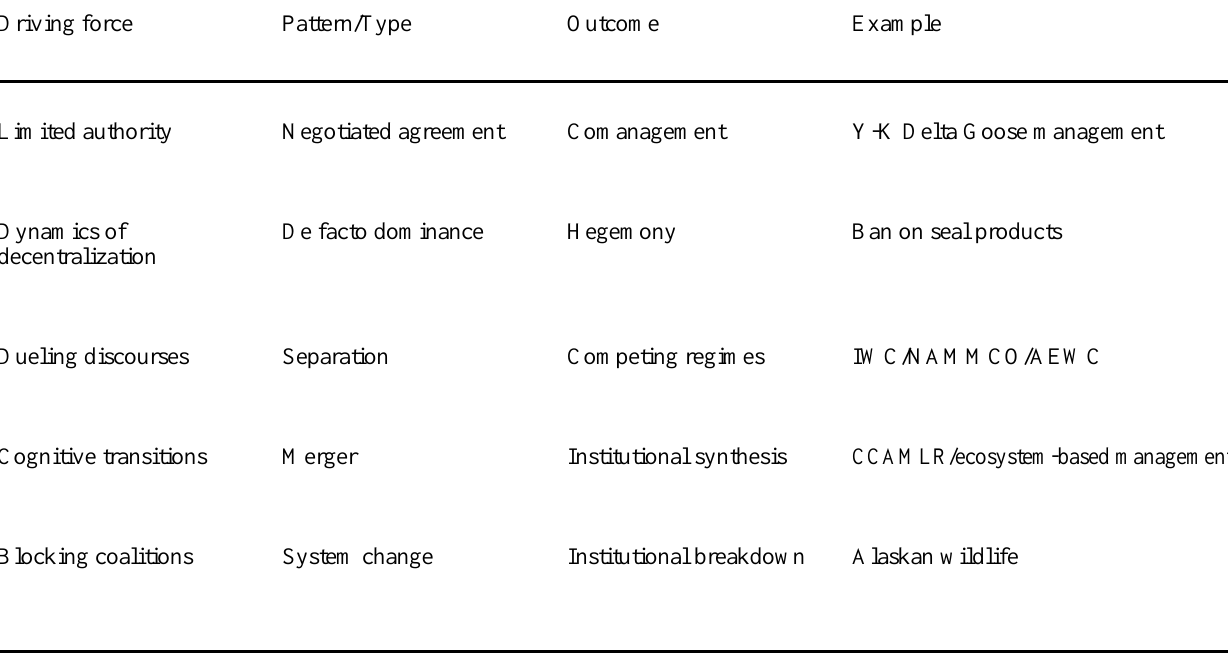
Table 1. Syndromes of cross-level, scale-dependent interplay. AEWC stands for Alaska Eskimo Whaling Commission; CCAMLR, Convention on the Conservation of Antarctic Marine Living Resources; IWC, International Whaling Commission; NAMMCO, North Atlantic Marine Mammal Commission; and Y-K, Yukon-Kuskokwim